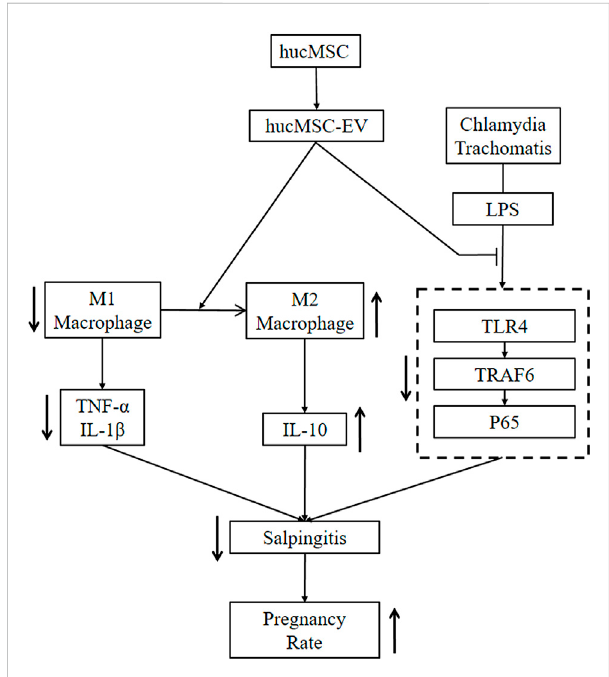
FIGURE 7 hucMSC-EV treat salpingitis by promoting macrophage polarization from M1 to M2 and inhibiting the TLR4 signaling pathway. hucMSC-EV downregulated M1 macrophages and cytokines TNF- α and IL-1 β and upregulated M2 macrophages and cytokine IL-10. hucMSC-EV downregulated the TLR4, TRAF6, and p65 proteins to treat salpingitis and upregulated the pregnancy